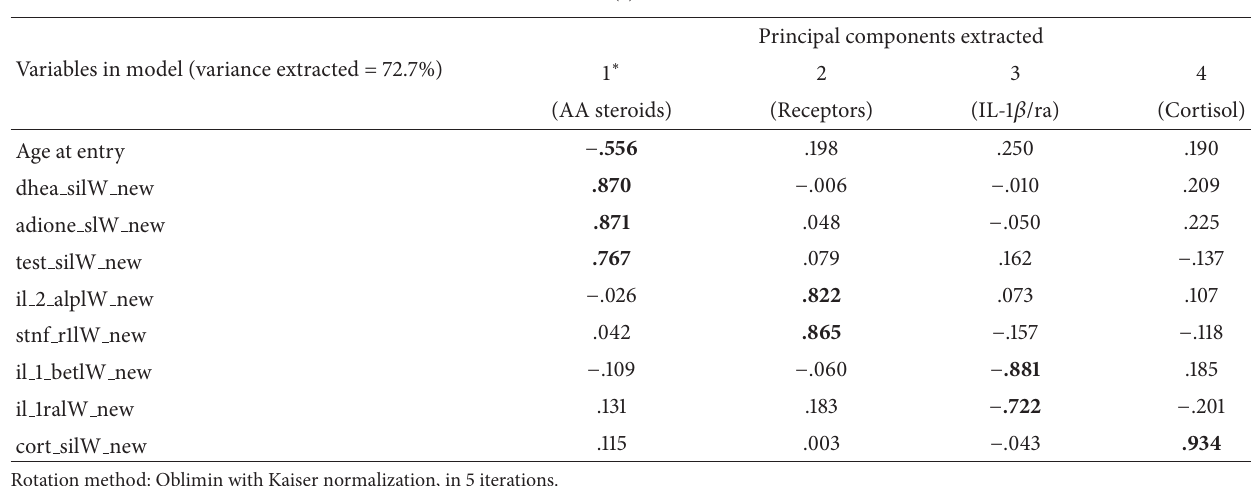
Table 8: (a) Control subjects ( 𝑁 = 214 ) pattern matrix. (b) Pre-RA subjects ( 𝑁 = 54 ) pattern matrix. (a)